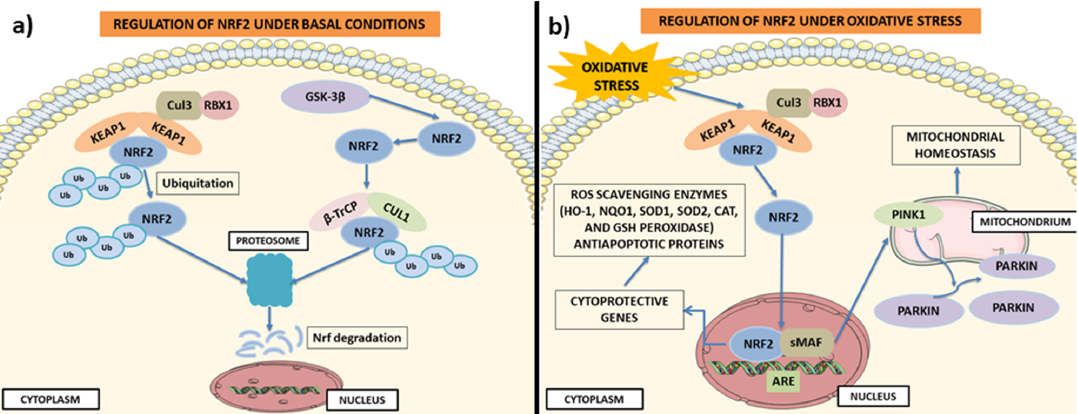
Figure 3. Regulation of the Nrf2 pathway. ( a ) Regulation of Nrf2 under basal conditions. Under basal conditions, Nrf2 is sequestered by Keap1 in the cytosol and ubiquitinated. The formation of the Keap1-Cul3-Rbx1 complex induces the degradation of the Nrf2 proteasome. In this way, Nrf2 expression is maintained in the cytosol at low levels. However, the degradation of Nrf2 can also be promoted by GSK-3 β . GSK-3 β by phosphorylating Nrf2 forms a recognition motif for the E3 ligase adapter β -TrCP. Formation of the GSK-3 β / β -TrCP/Cul1 complex promotes Keap1-independent degradation of Nrf2. ( b ) Regulation of Nrf2 under oxidative stress. When cells are under severe oxidative stress, Nrf2 is released from Keap1 binding and is translocated from the cytosol to the nucleus. In the nucleus, it binds to ARE gene sequences and promotes the transcription of cytoprotective genes responsible for the translation of ROS scavenging enzymes (HO-1, NQO1, SOD, SOD2, CAT and GSH peroxidase) and antiapoptotic proteins. Furthermore, Nrf2 positively regulates PINK1 by promoting mitochondrial homeostasis through several mechanisms, such as the removal of